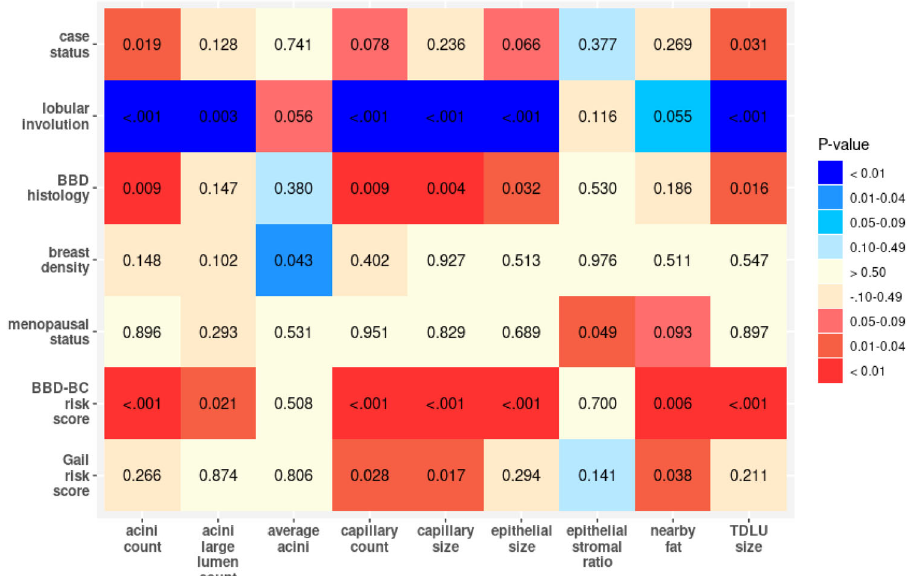
Fig. 3 Analysis of AI-derived features versus clinical variables: age-adjusted associations of AI-derived breast biopsy biomarkers with demographic and clinical variables of subjects. Numbers indicate p values of association. Blue shades indicate negative associations between demographic/clinical variable and AI feature (i.e., feature value decreases as variable increases), whereas red shades indicate positive